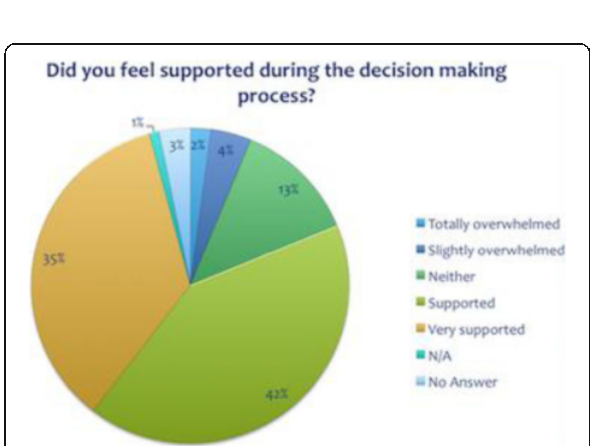
Fig. 93 (abstract A214). Support during the decision making